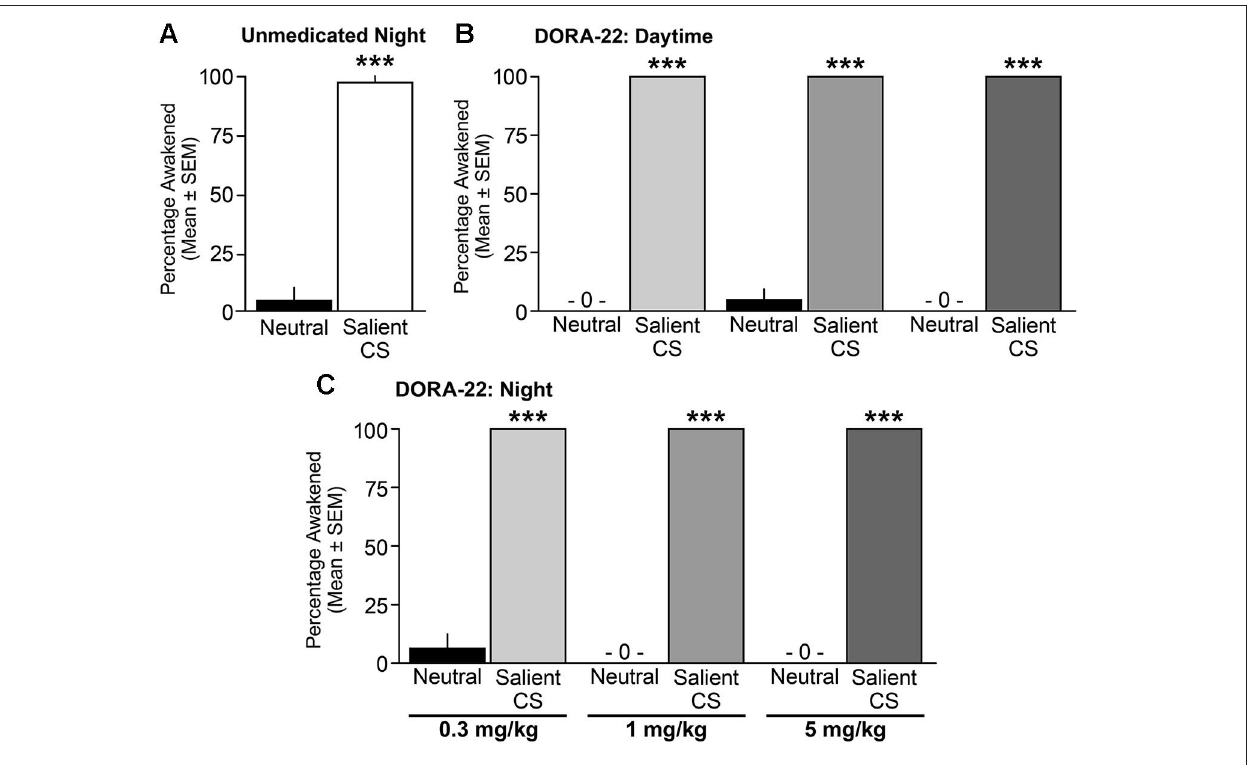
(B) DORA-22-induced daytime sleep, and (C) DORA-22-induced night sleep with the neutral acoustical stimulus and salient conditioned stimulus (CS).